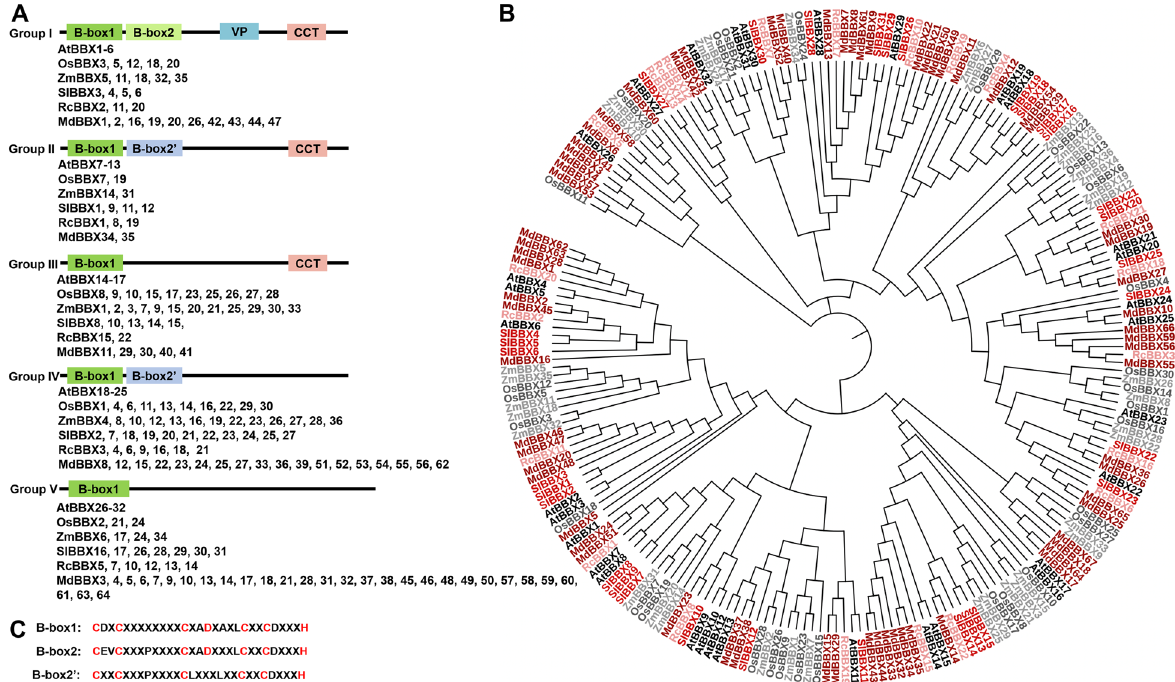
Fig. 1 Phylogenetic relationship, protein structure and architecture of the conserved BBX proteins in plants. A Structures of the BBX proteins with the composition of the domains in Arabidopsis thaliana , rice ( Oryza sativa ), maize ( Zea mays ), tomato ( Solanum lycopersicum ), rose ( Rosa chinesis ) and apple ( Malus domestica Borkh ). B Molecular phylogenetic analysis of BBX proteins in Arabidopsis thaliana , rice ( Oryza sativa ), maize ( Zea mays ), tomato ( Solanum lycopersicum ), rose ( Rosa chinesis ) and apple ( Malus domestica Borkh ). C Consensus sequences of B-box1, B-box2 and B-box2’ in Arabidopsis, red color indicates the conserved amino